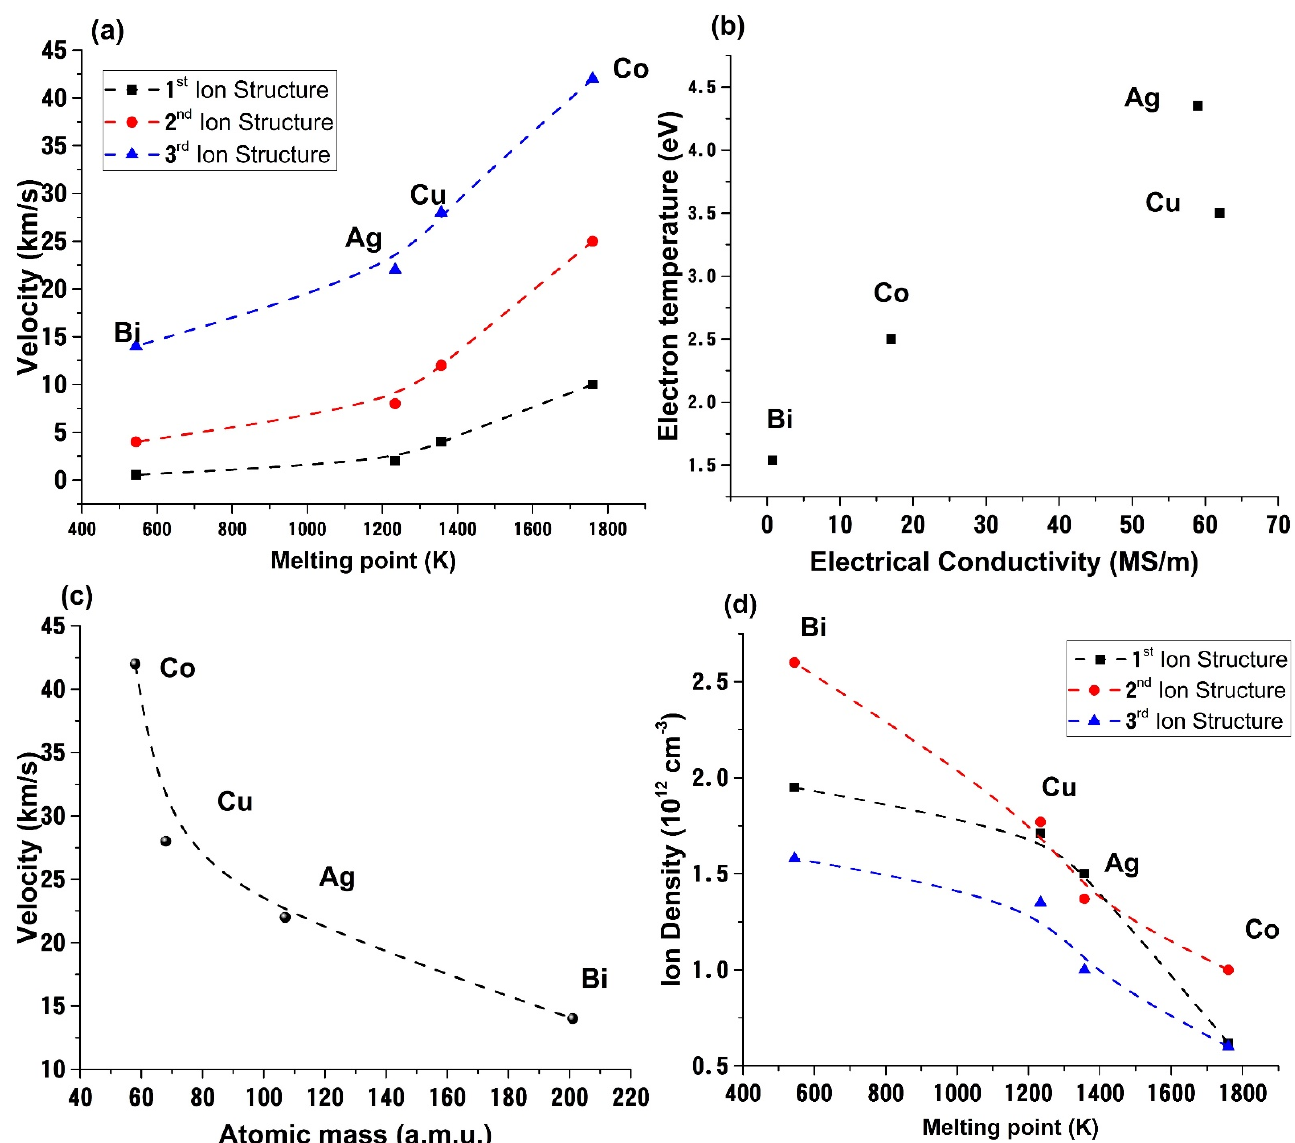
Figure 6. Dependence of expansion velocity on melting point ( a ), electron temperature on target electrical conductivity ( b ) expansion velocity on atomic mass ( c ) and ion density on melting point ( d ); lines are guide to the eye .